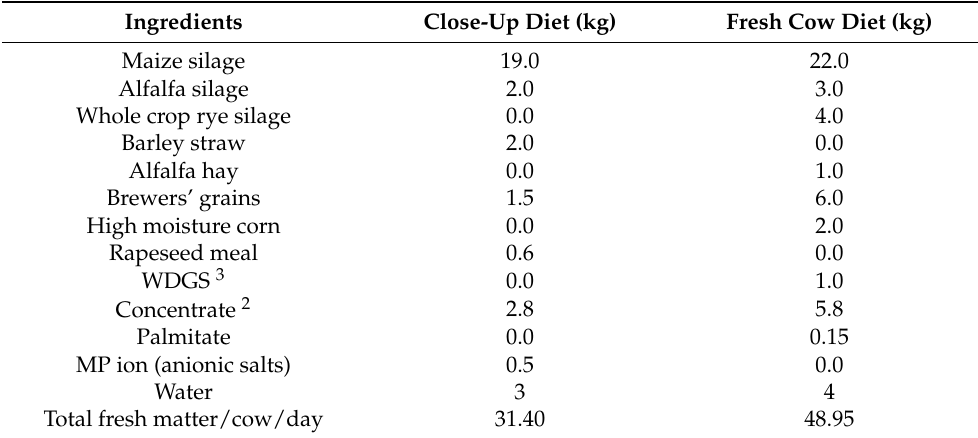
Table 7. Composition of the control diet on a fresh matter basis 1